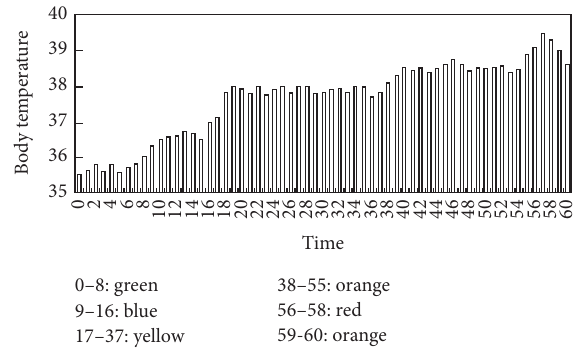
Figure 10: The corresponding color of 0–60-moment temperature